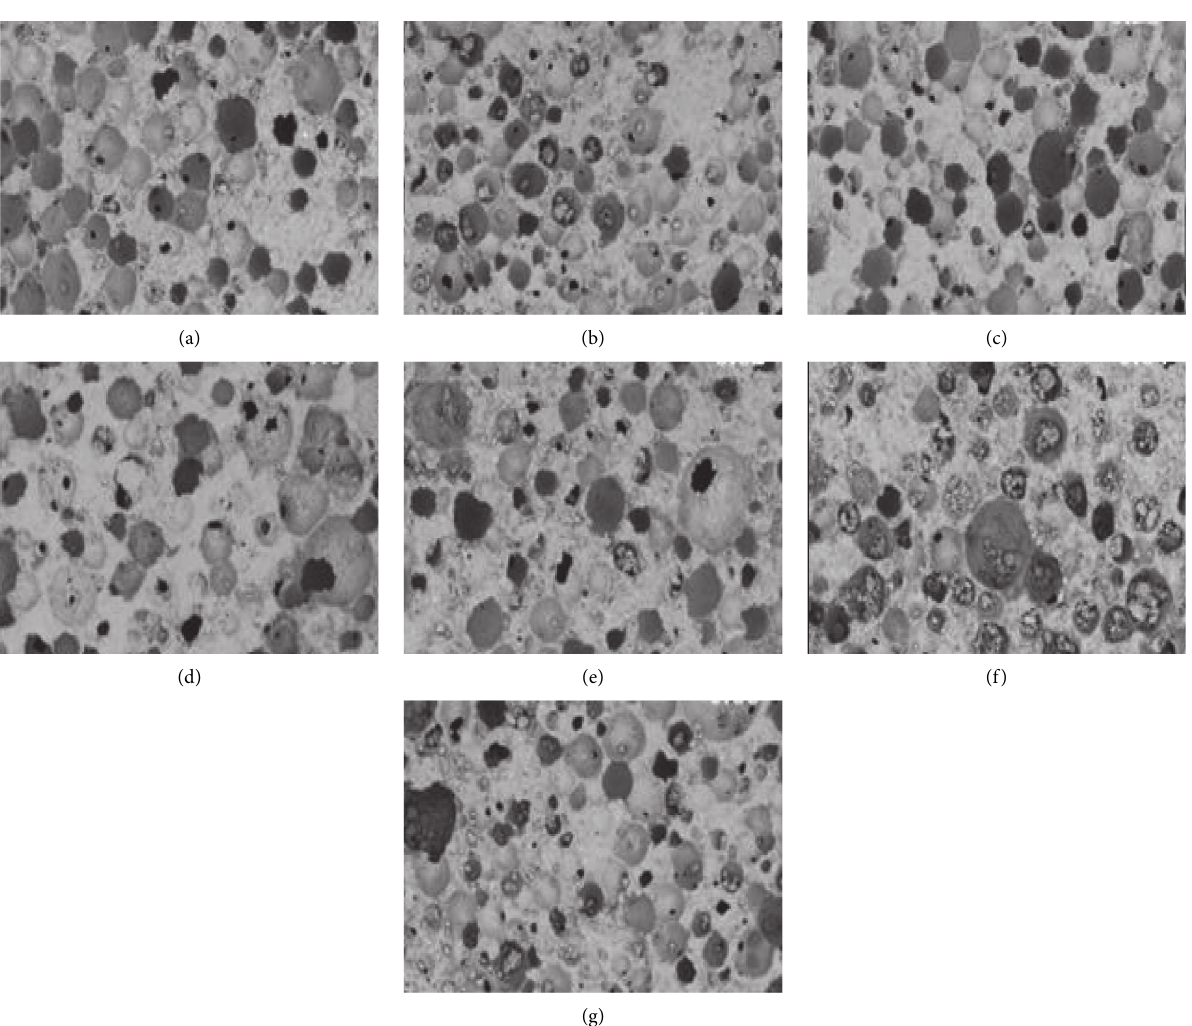
Figure 17: SEM images of foamed concrete under different water-cement ratios: (a) 0.54; (b) 0.56; (c) 0.58; (d) 0.60; (e) 0.62; (f) 0.64; (g)